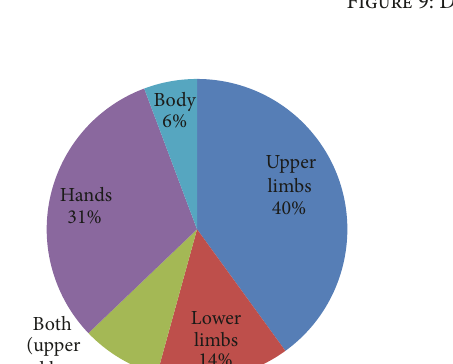
Figure 9: Disabilities for solutions.